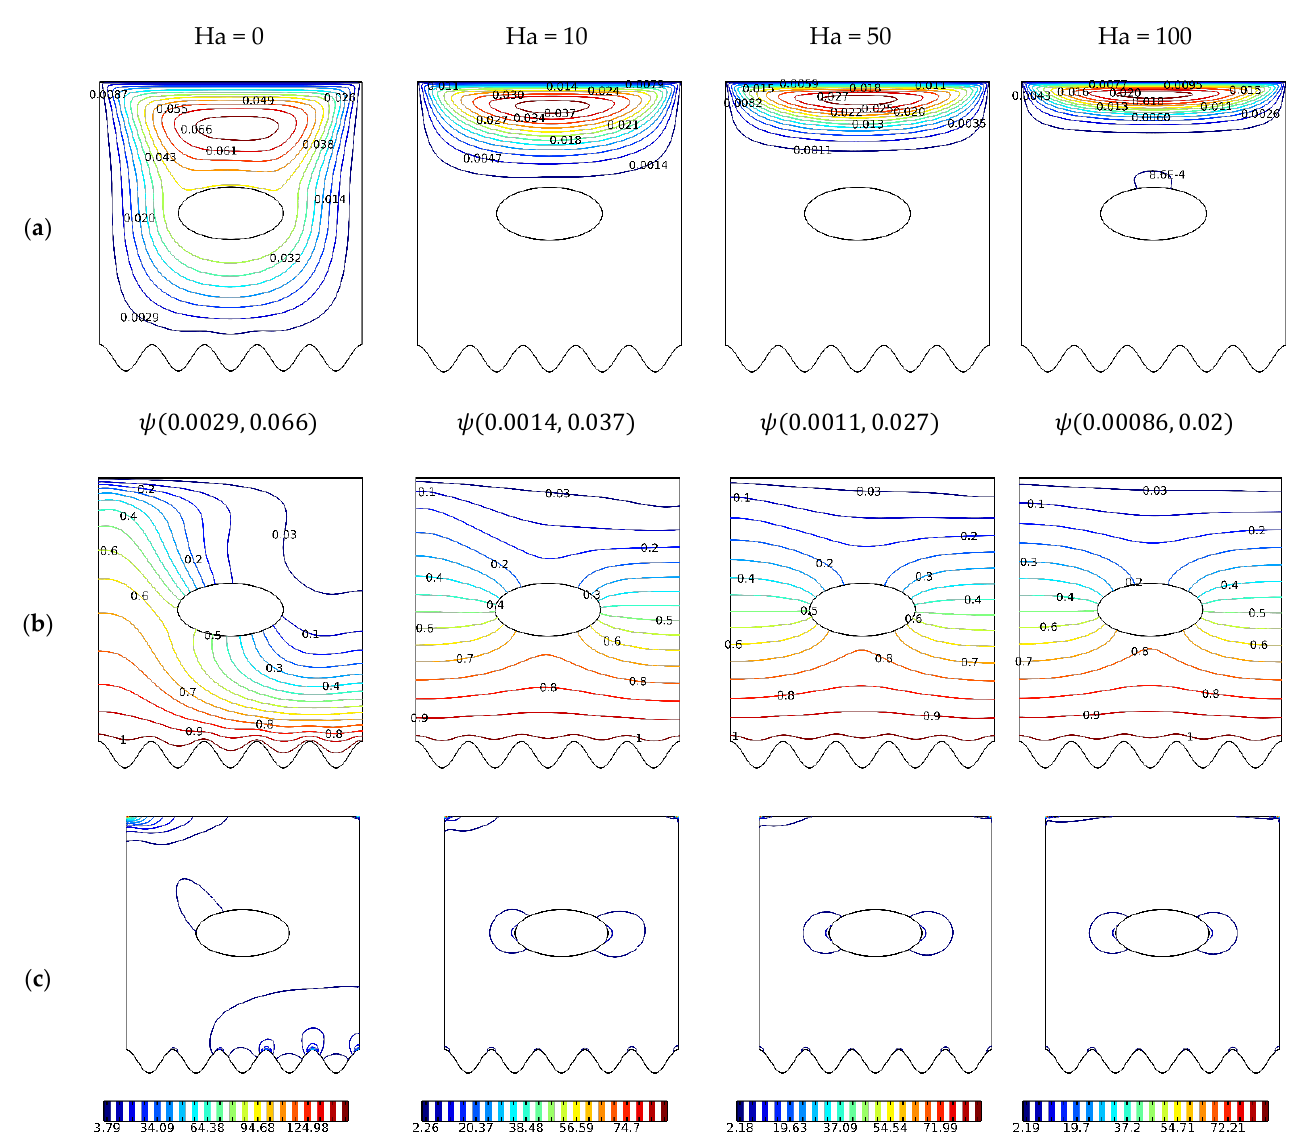
Figure 8. Streamlines, isotherms, and isentropic contours: γ : 0°; N = 4; Ha = 0, 25, 50, 100; Ri = 1; φ = 0.02. ( a ) ψ ; ( b ) Θ ; and ( c ) S.